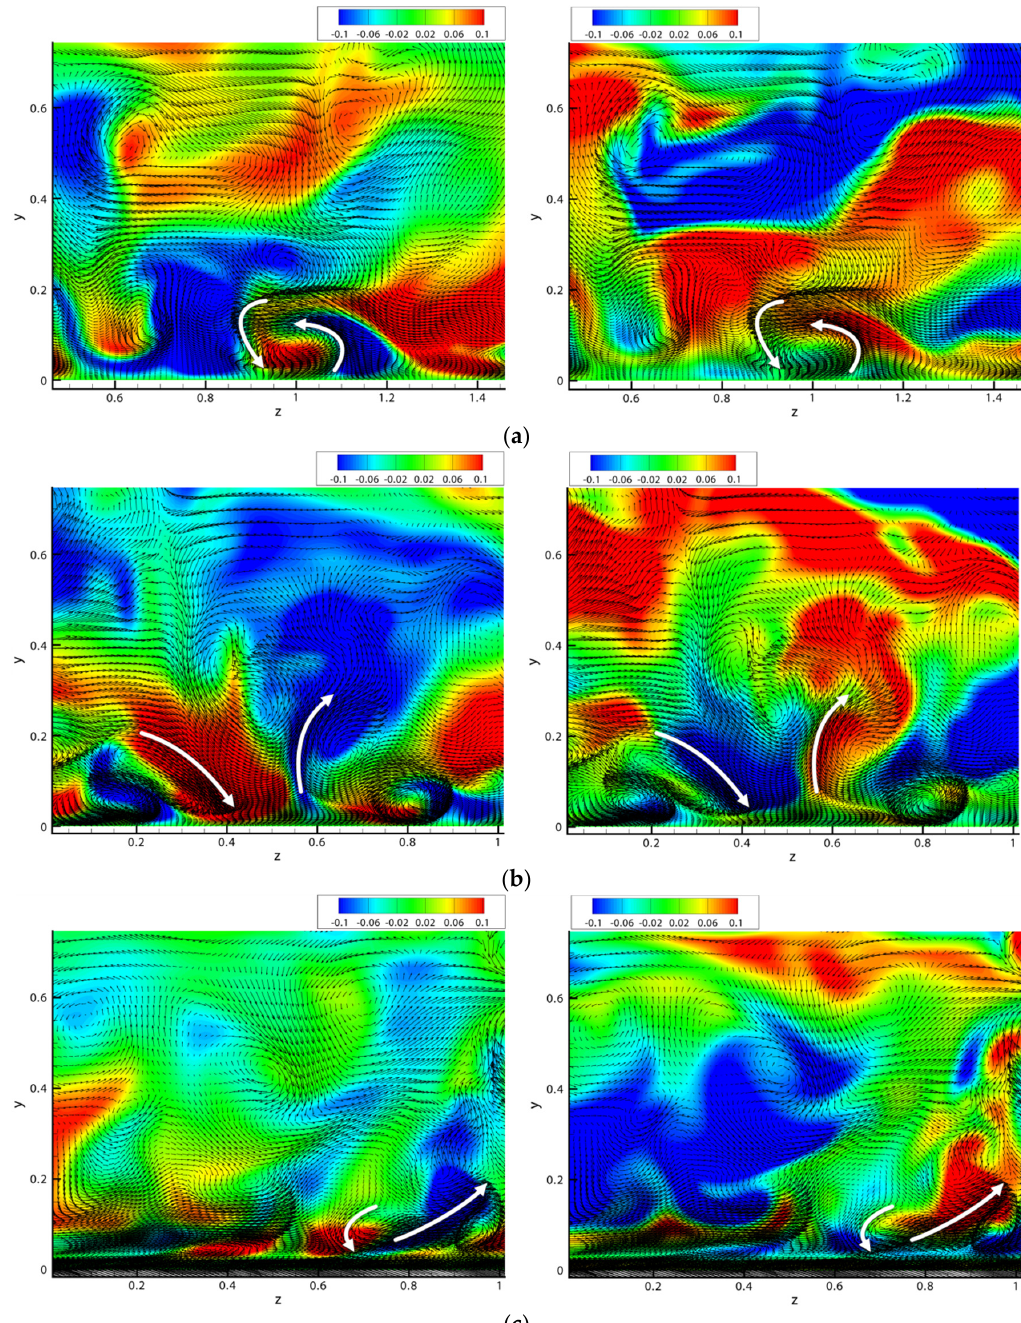
Figure 16. Distributions of velocity vector (cid:4666)(cid:1875)′′,(cid:1874)′′(cid:4667) , streamwise velocity fluctuation (cid:1873)′′ ( left ) and temperature fluctuation (cid:1846)′′ ( right ) at x = 40.775 in instantaneous flow field: ( a ) Case 0; ( b ) Case P150A3; and ( c ) Case P150A20. The white arrows represent the local sweep and ejection motions. For the cases with SWO, the streamwise vortices can still be seen as major structures in the boundary layer and their sweep and ejection motions still dominate the turbulent transport, although the strength of streamwise vortices might be reduced, especially for Case P150A20.